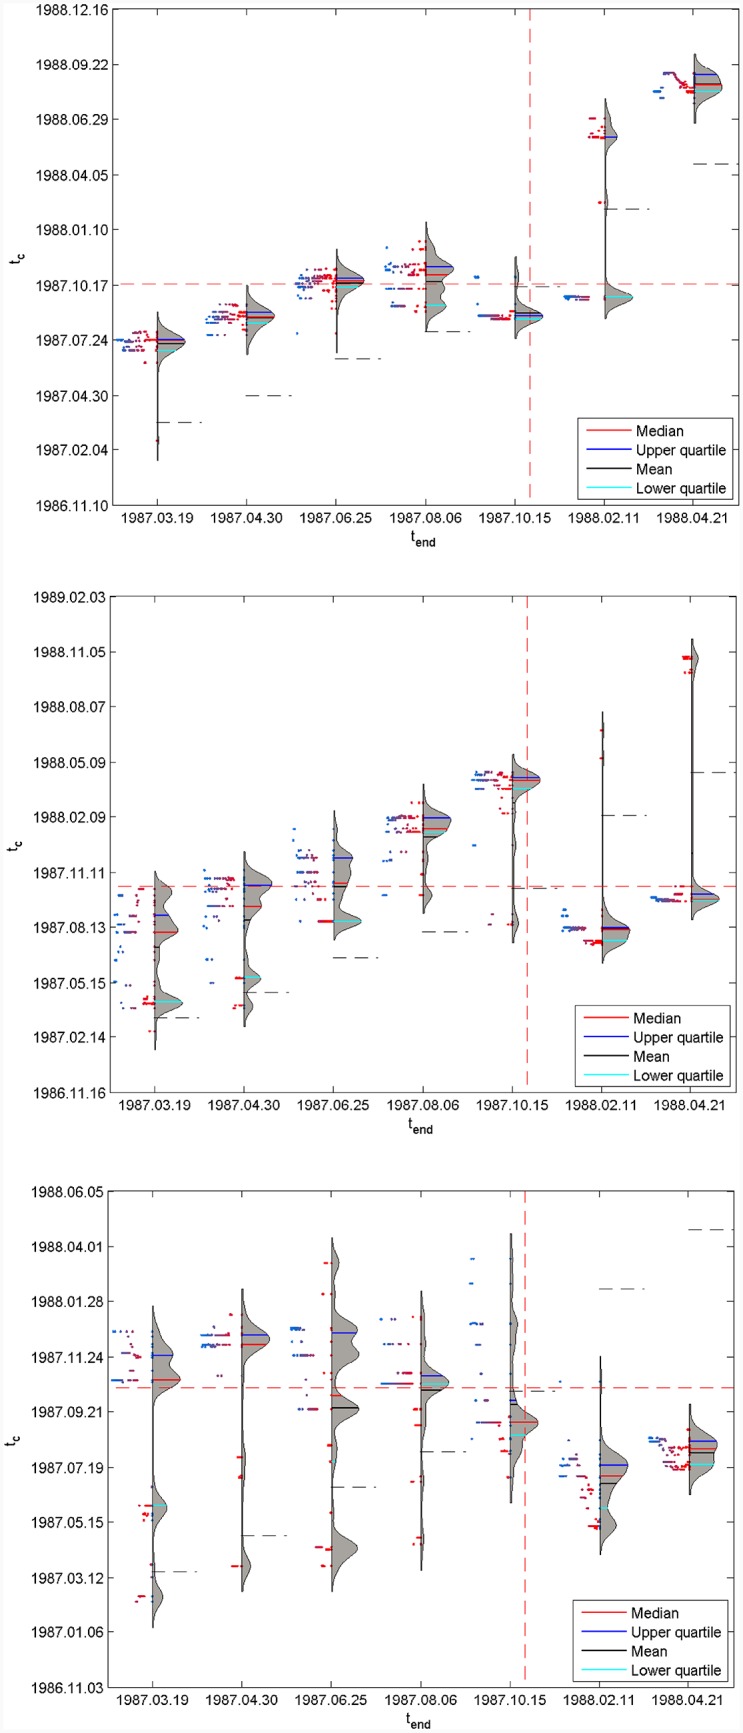
Same as Fig 4 but for the search space m ∈ [0.1, 0.9], ω ∈ [6, 13] and tc ∈ [tend − 0.20dt, tend + 0.20dt].